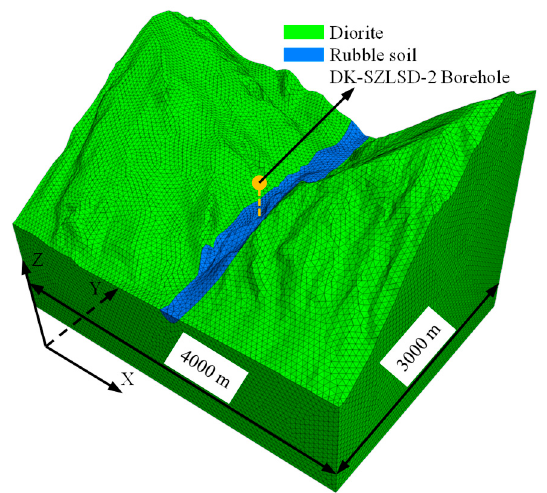
Figure 7. The three-dimensional numerical model after meshing.